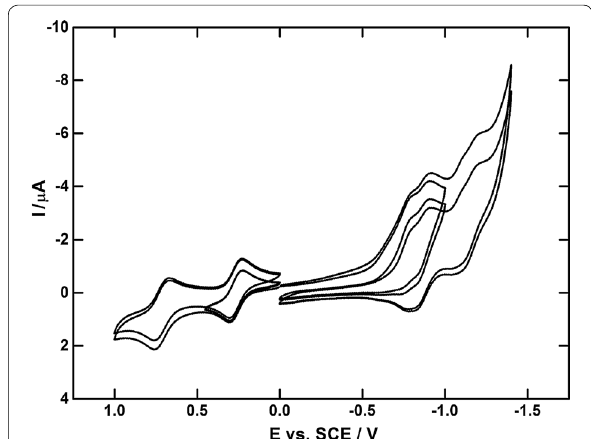
Fig. 8 CV curves of the oxidation (reduction) of compound 3 at Pt